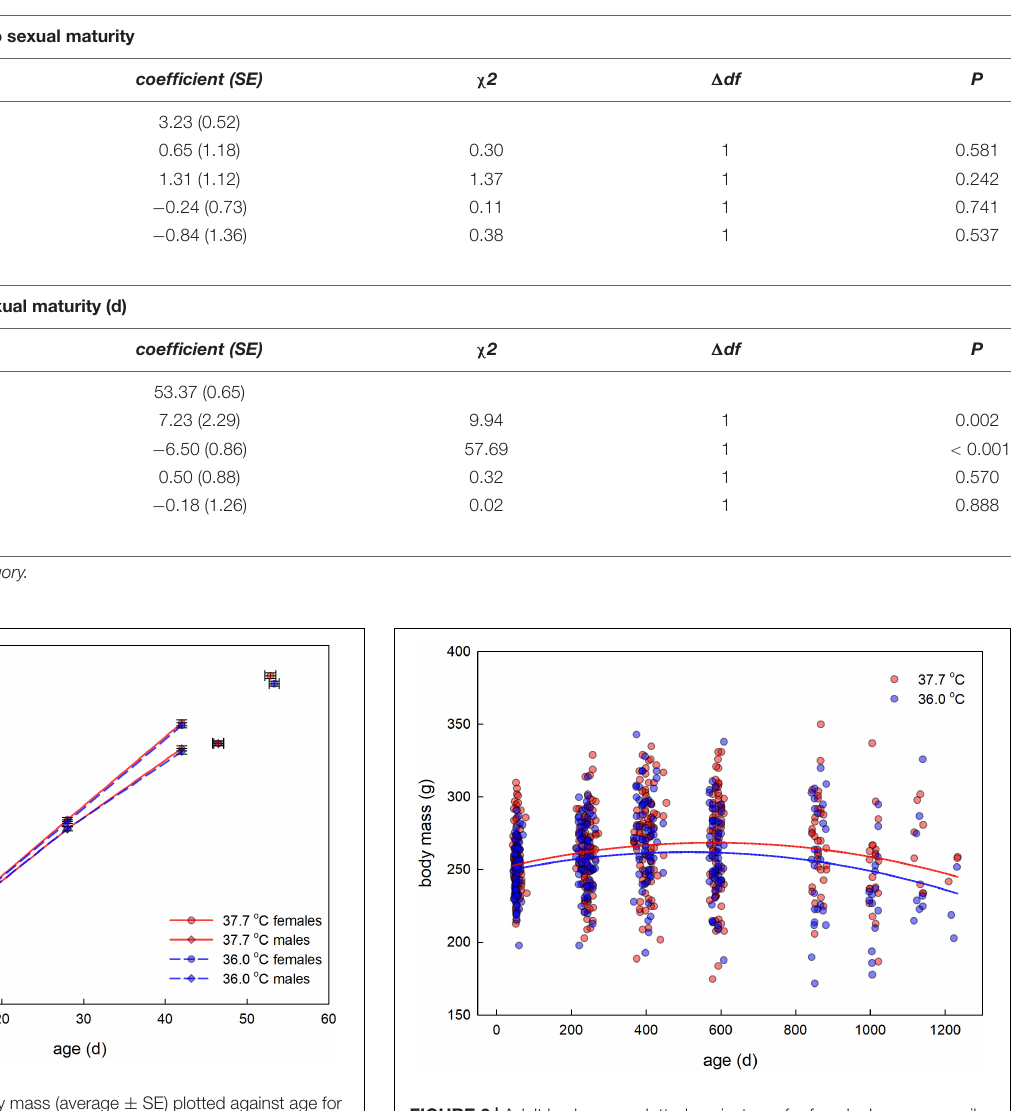
FIGURE 2 | Adult body mass plotted against age for female Japanese quail incubated at 37.7 ◦ C ( n = 99 females) or 36.0 ◦ C ( n = 79 females). The lines represent the model prediction (see Table 3 ) for each incubation